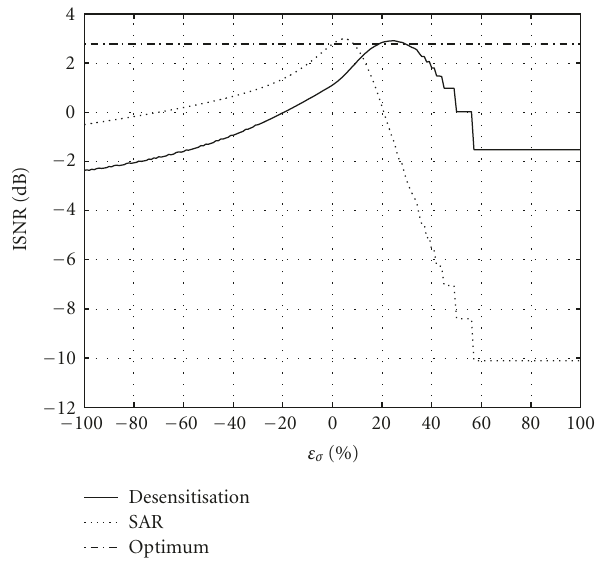
Figure 14: Distributions of ISNR obtained by both the SAR restora- tion and our desensitised method when the inclination of the mo- tion PSF is altered from 45 degrees according to the error ε θ , keep- ing the estimated length parameter to the actual value of 15 pix- els. Regarding noise, a Gaussian artefact is applied in relation to a BSNR of 20 dB keeping the variance estimation unchanged. Besides, a horizontal line is included symbolizing the constant value of ISNR reached when optimum estimates are considered in the Wiener fil-